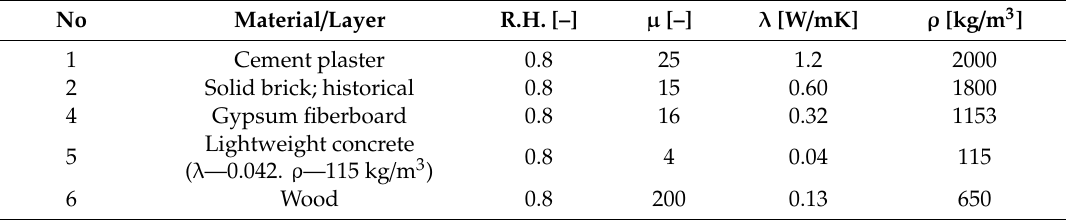
Table 4. Physical parameters of wall materials accepted for numerical